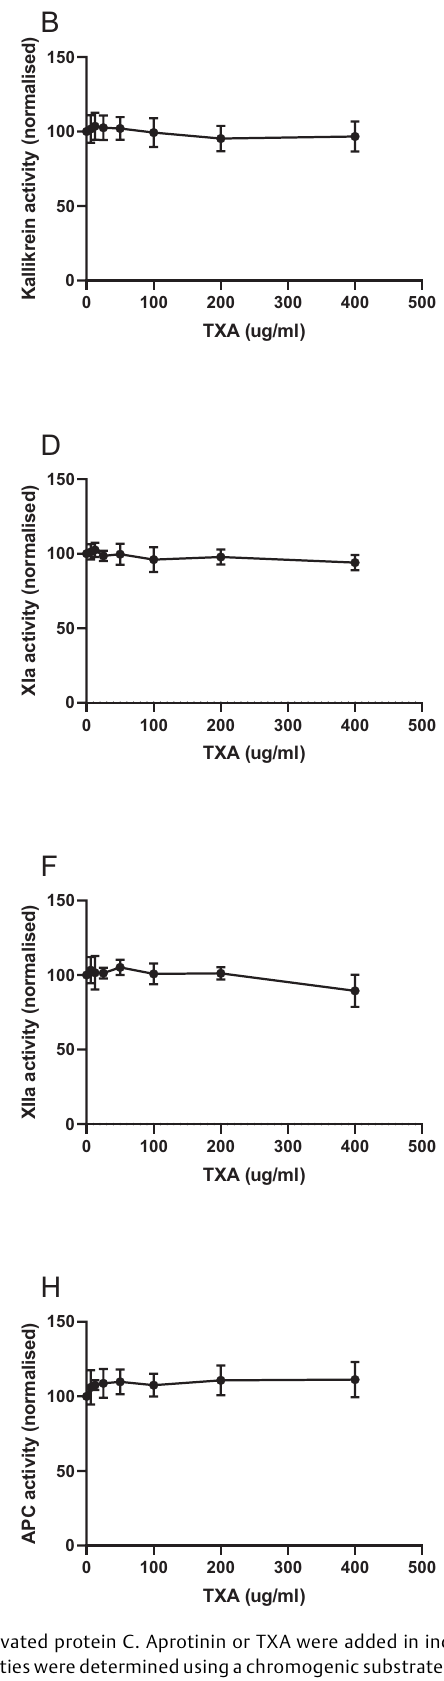
TH Open Vol. 5 No. 3/2021 © 2021. The